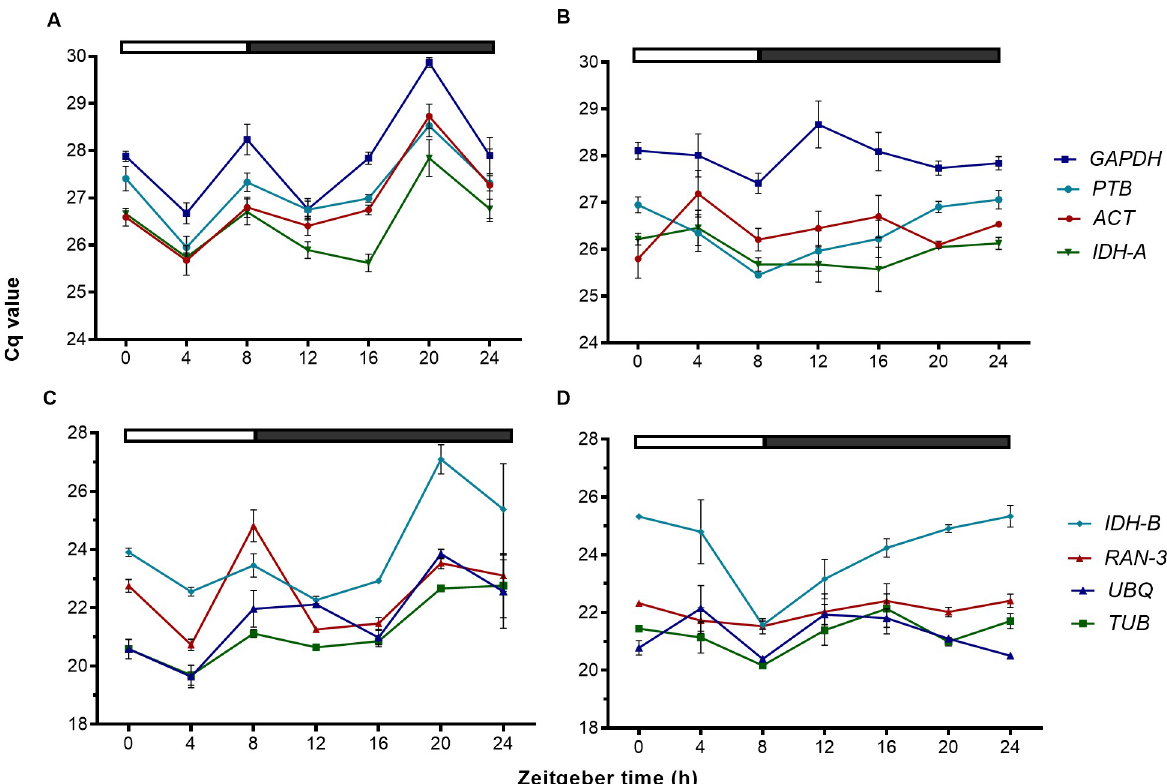
Fig 2. Expression profiles of candidate genes. Cq values from 21 samples (three technical replicates of three biological replicates) taken at seven different points of the day for (A,C) Titicaca and (B,D) CHEN-109. Two groups of genes are represented: (A,B) high Cq value and (C,D) low Cq value. The bar at the top indicates light (empty box) and dark (filled box) phases. The error bars represent the SEM between biological replicates.